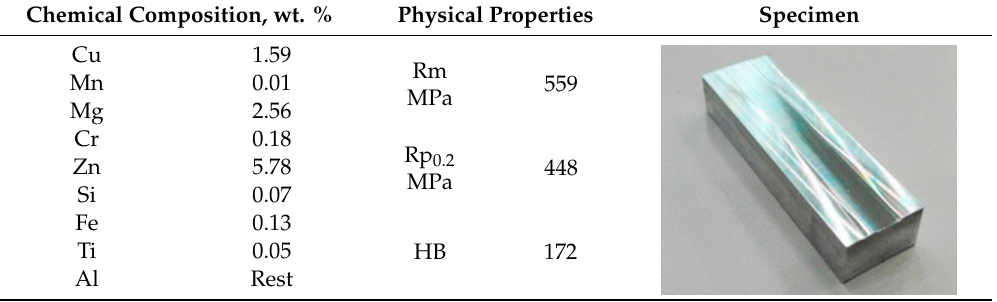
Table 1. Chemical composition and physical properties of AW 7075-T651 aluminium alloy [2]. Chemical Composition, wt. %